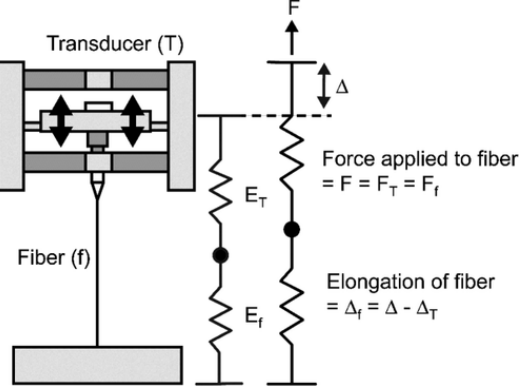
Figure 10. Schematic of microfiber–transducer configuration, Reproduced form [118] with permission of AIP Publishing.